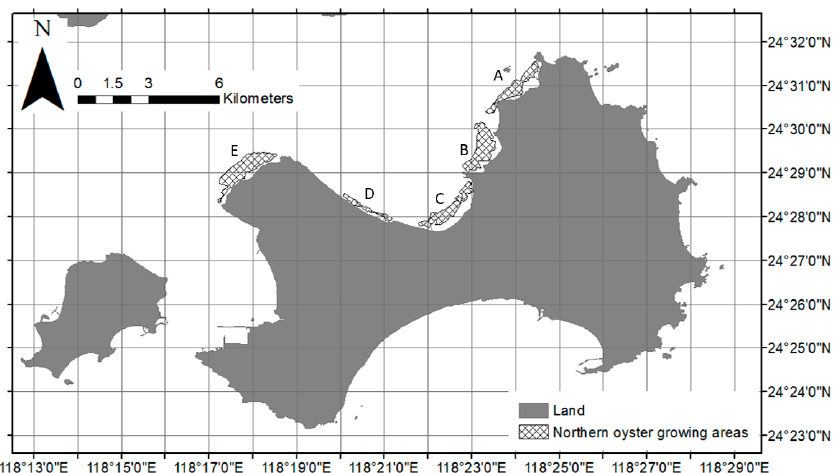
Figure 2. Important oyster-growing areas (A-E) in northern Kinmen.